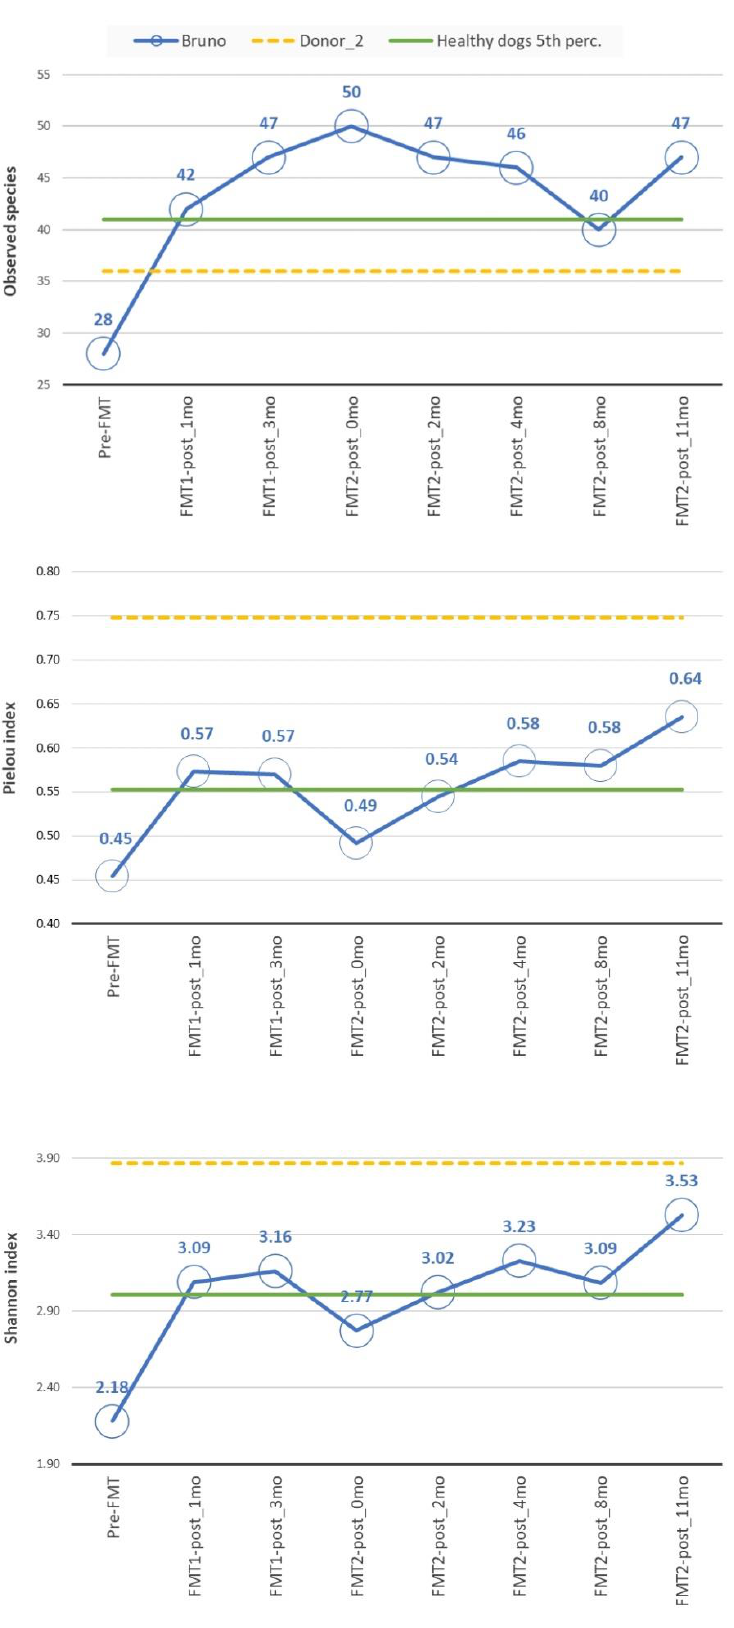
Figure 2. Alpha diversity analysis. The values for species Richness ( top ), Pielou index ( middle ) and Shannon index ( bottom ) are reported as a blue polyline for the patient (Bruno), while the reference values for the FMT capsule and the minimum healthy threshold (5th percentile of healthy samples’ values) are reported in dashed yellow and solid green, respectively.